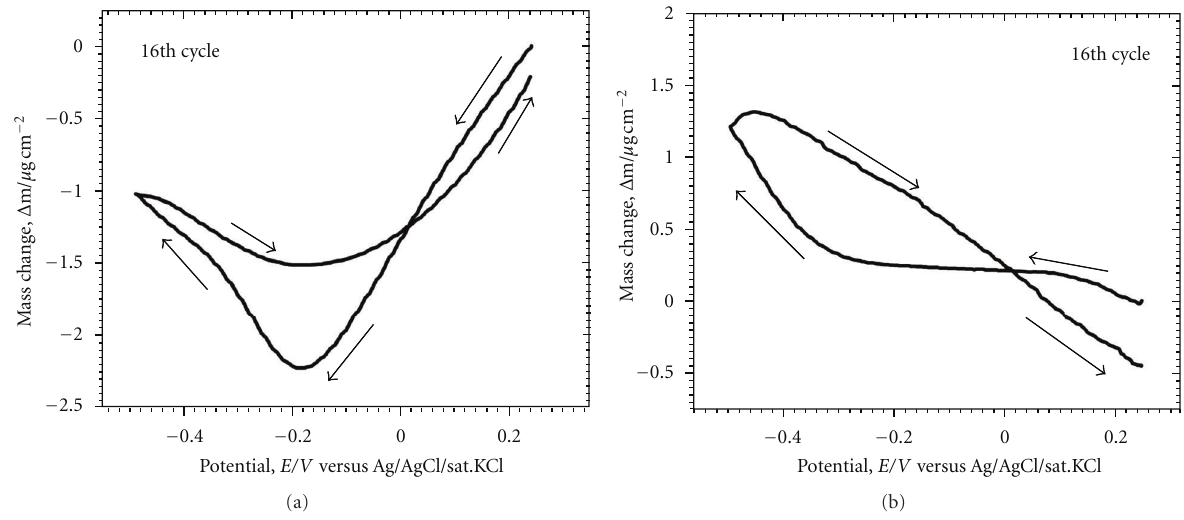
Figure 7: Mass change of the PPy-PMo layer and bilayer of PPy-PMo/PPy-DoS during the potentiodynamic reduction and oxidation in 3.5% NaCl solution. The data was a result of the 16th redox